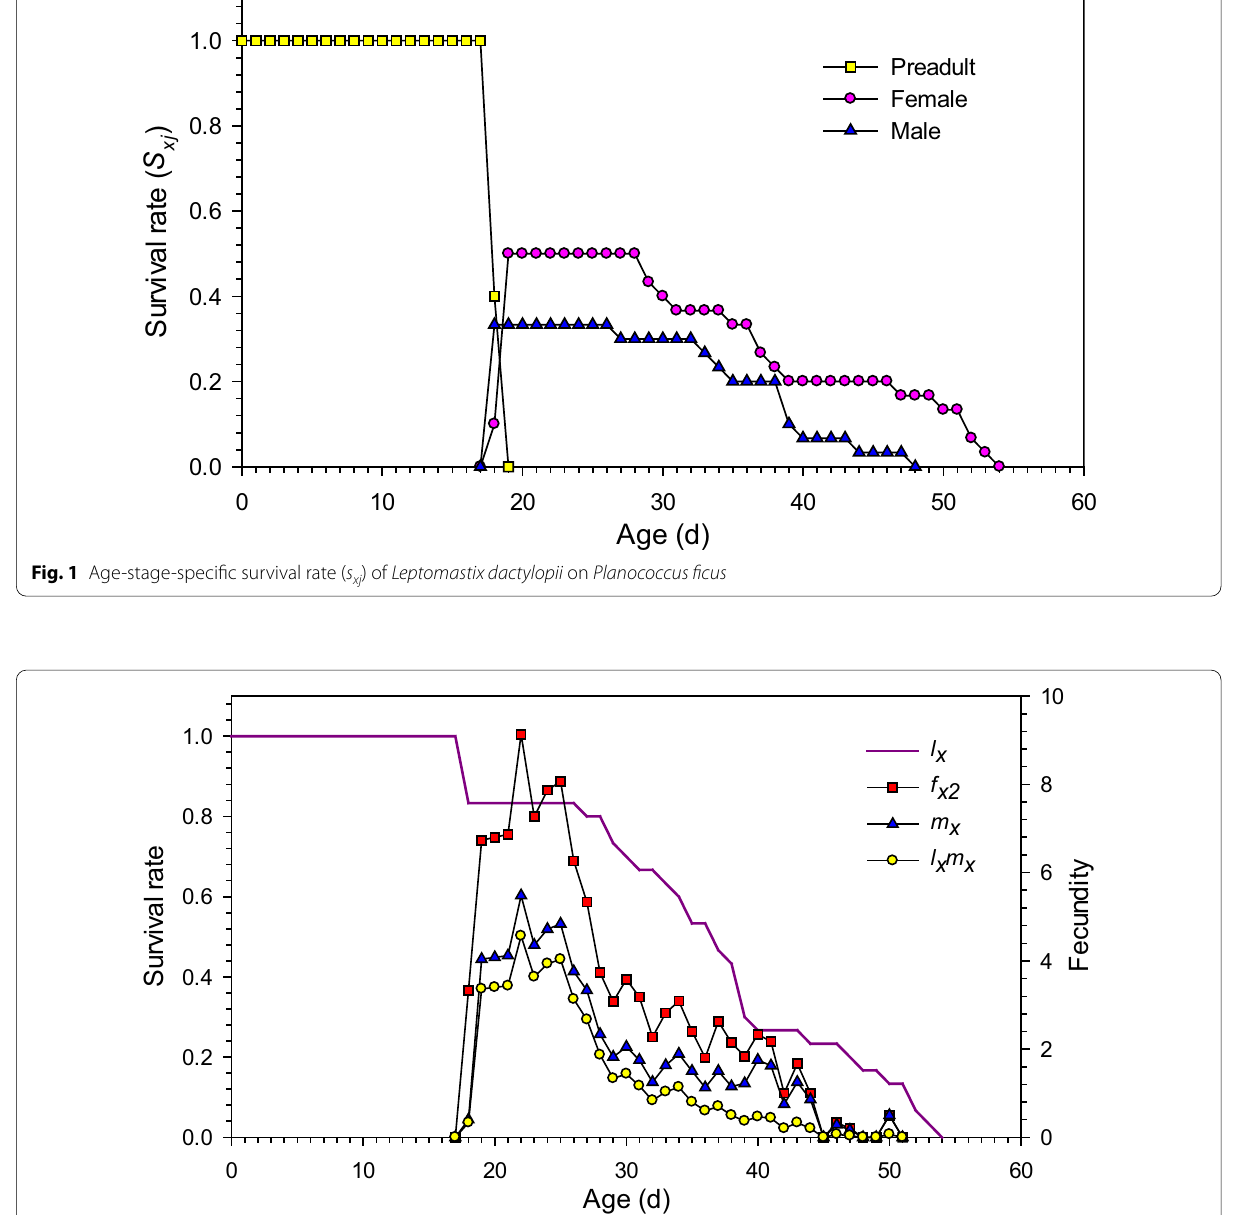
Fig. 2 Age-specific survival rate ( l x ), female age-specific fecundity ( f x 2 ), age-specific fecundity ( m x ), and age-specific maternity ( l x m x ) of Leptomastix dactylopii on Planococcus